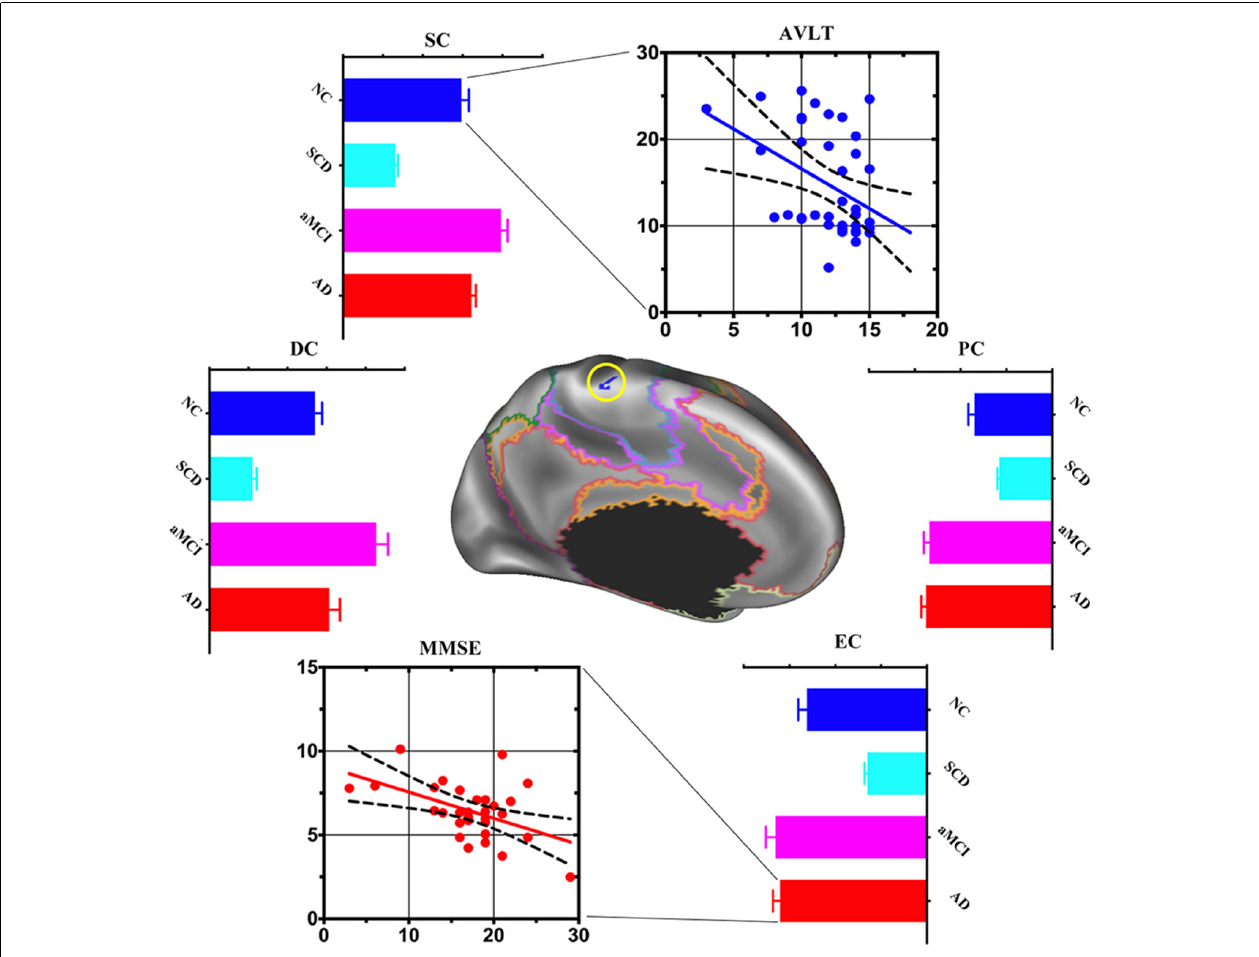
FIGURE 2 | Post hoc cluster-level analyses in the left somatomotor network. Multi-scale centrality and behavioral performance in the left somatomotor network region among NC, SCD, aMCI and AD. Compared with NC, the area of the left somatomotor network showed centralities change at local, meso and global scales in AD progression. Mean DC, SC and EC values decreased in SCD, increased in aMCI and AD. The scatter plot exhibited negative association between: (1) mean SC values and auditory verbal learning test (AVLT)-Recognition scores in the NC ( r = − 0.4093, p < 0.05); and (2) mean EC values and Mini-Mental State Examination (MMSE) total scores in the AD ( r = − 0.4908, p <